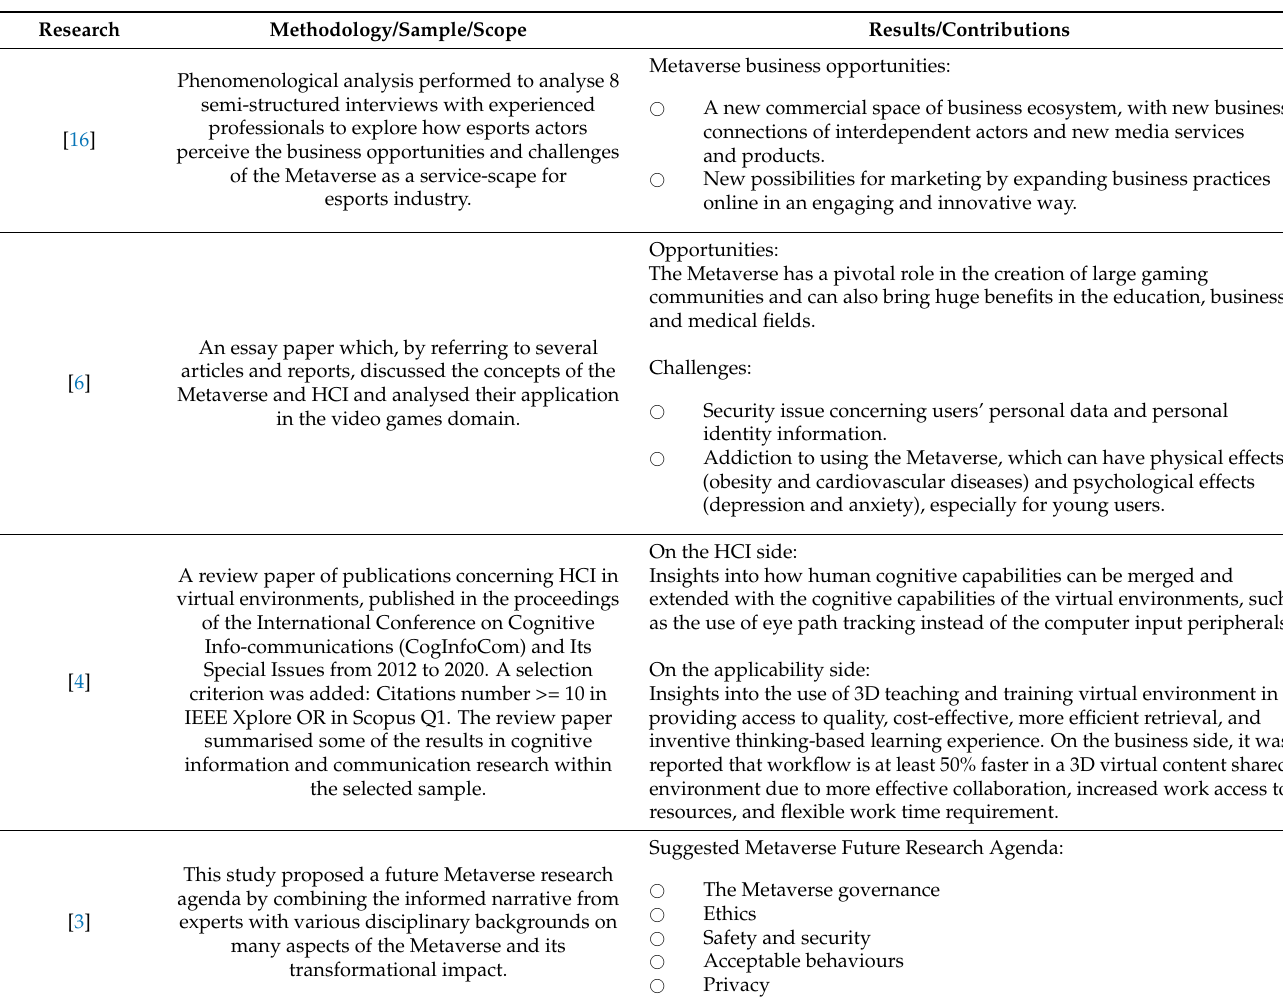
Table 1. HCI in Metaverse